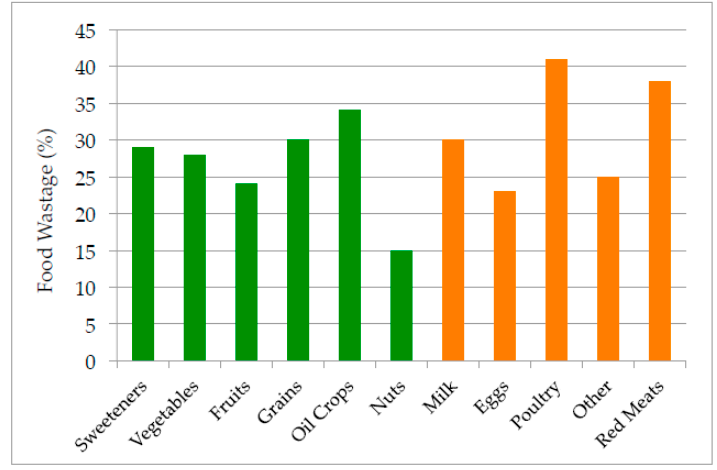
Figure 2. Estimates of wastage for various plant-based and animal-based foods are presented for the USA. Based on data provided by Buzby et al. [24].